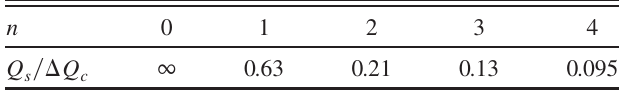
TRANSVERSE MODES AND INSTABILITIES OF A . . TABLE I. Estimated instability thresholds of Gaussian bunch with 3 (cid:15) truncation (lower radial modes, no chromaticity).